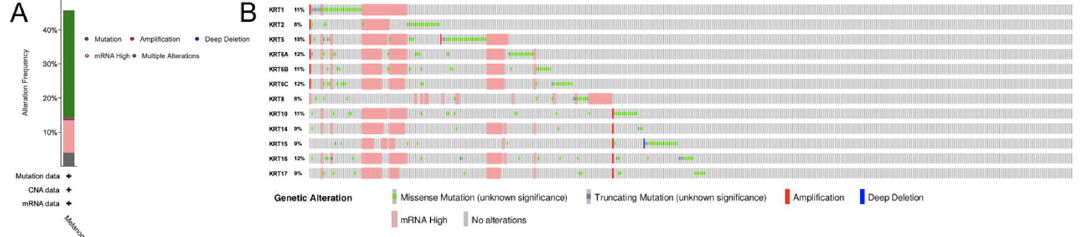
Figure 6. Genetic alterations in KRT s family members (cBioPortal). A visual summary of alteration based on a query of 12 KRTs , which was altered in 203 (45.72%) of 444 sequenced cases/patients.